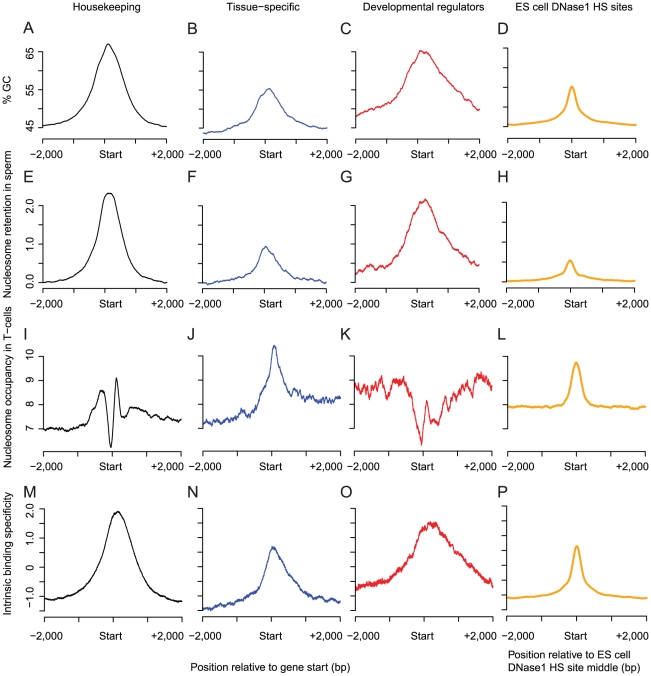
GC-content predicts variation in nucleosome retention among gene classes and at distal regulatory regions.GC-content signatures around the start sites of (A) housekeeping genes (black), (B) tissue-specific genes (genes expressed in a single tissue, blue) and (C) developmental regulators (red). Average nucleosome retention in sperm (E–G), average nucleosome occupancy in T-cells (I–K), and average nucleosome affinity around the start sites (M–O) of the same three classes of genes. Nucleosome retention in sperm, but not occupancy in T-cells, mirrors the GC-content and the intrinsic nucleosome affinity. The three gene classes contain 7,308 housekeeping genes, 1,686 tissue-specific genes and 538 transcription factors that regulate development. GC-content (D), nucleosome retention in sperm (H), nucleosome occupancy in T-cells (L), and nucleosome affinity (P) are also enriched at DNase I hypersensitive sites (HS) identified in embryonic stem (ES) cells. The average scores were calculated from 64,217 DNase I HS sites from ES cells located at least 1 kb away from any gene.